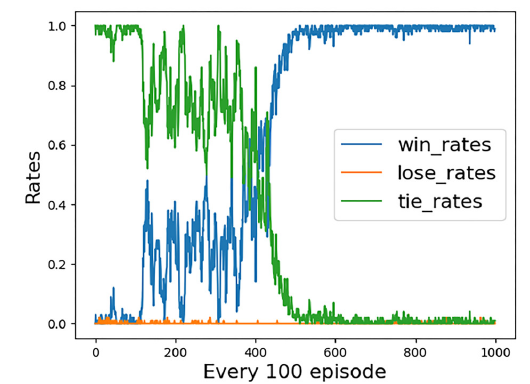
Figure 12. Our UCAV reward change curve in case 2.